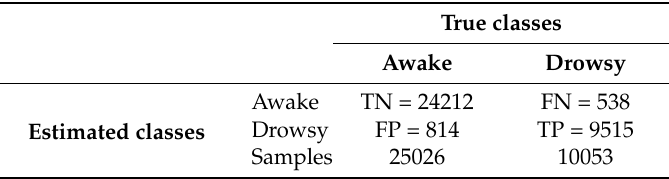
Table 4. Confusion matrix for proposed